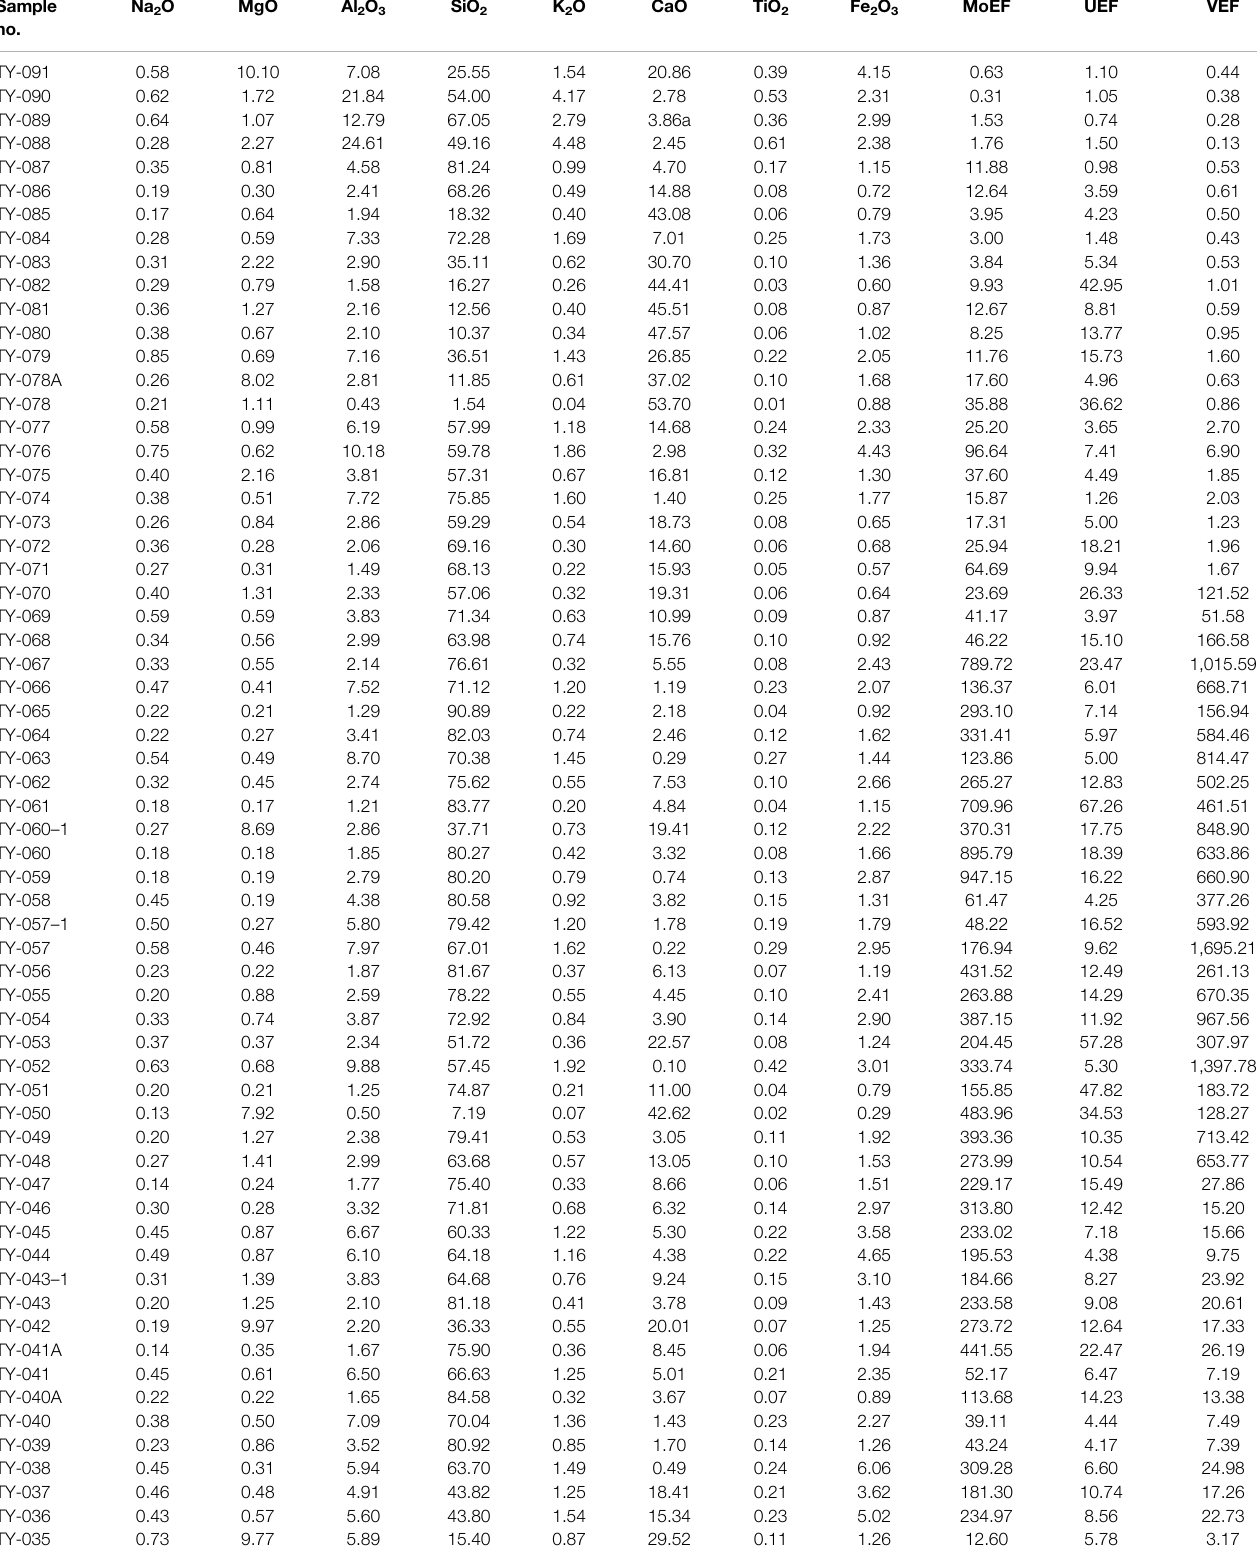
TABLE 1 | Inorganic elements of Dalong Formation in Longfeng quarry section. Sample